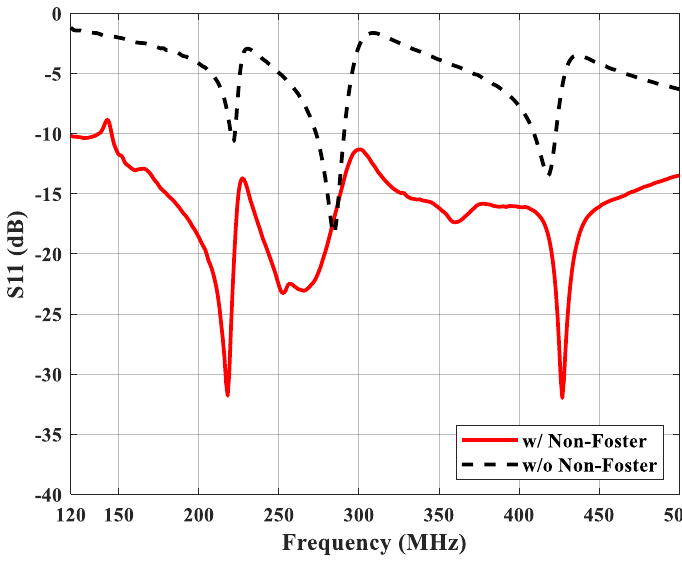
Figure 16. Measured reflection coefficients.